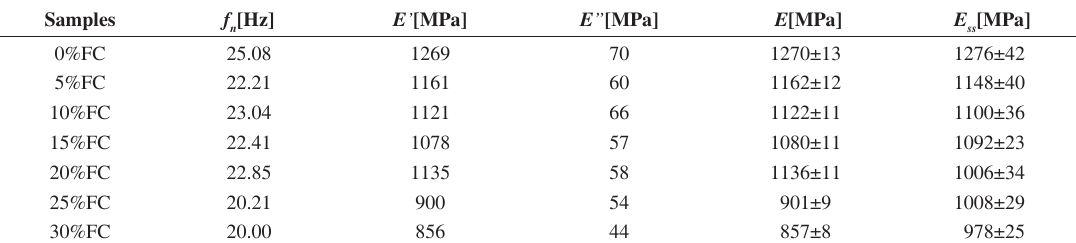
), storage ( E ’), loss ( E ”), complex modulus ( E ) and Young modulus from stress-strain tests ( E n